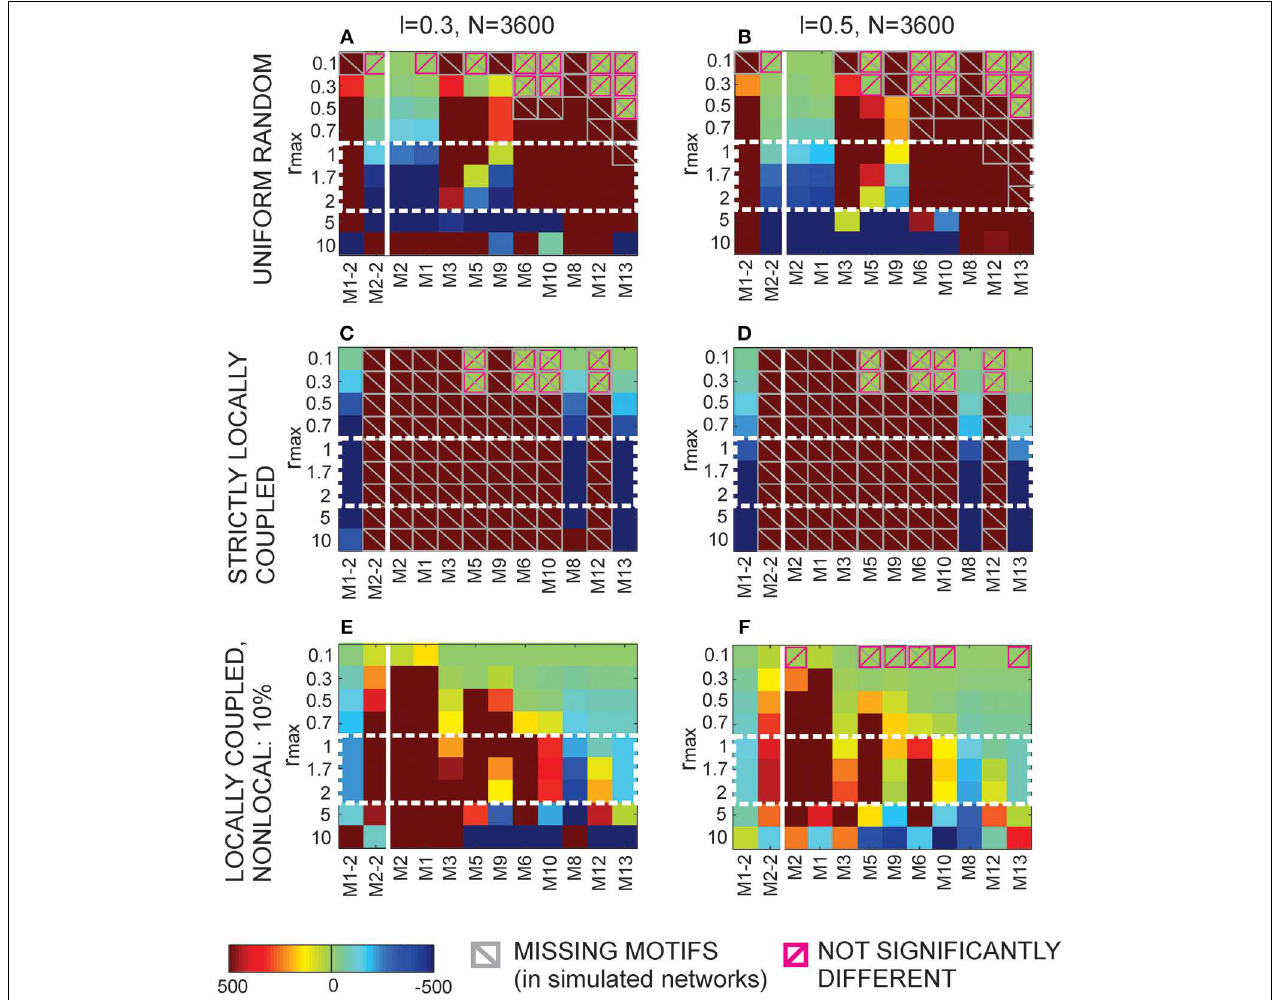
the same format as Figure 7 , while the color bar at the bottom explains the FIGURE 8 | Comparison of the results from Figure 7 with the motif color code. The crossed gray squares correspond to zero motif counts in the counts obtained from simulated uniform random and locally coupled simulated networks, i.e., both the mean value and the variance are zero. The networks. The color maps show the t-scores for all motifs (shown on the x crossed pink squares are the cases when our model and the simulated axis) and all considered values of the normalized effective radius (shown on networks give statistically the same results (the t -test with 5% significance the y axis). The comparison is done for two population densities, a denser level). (A,B) Comparison with the uniform random networks. (C,D) one ( l 0 . 3 , left column) and a sparser one ( l 0 . 5 , right column). A positive = = Comparison with the strictly locally coupled networks. In these networks all t-score indicates a bigger expected number of motifs in our model than in connections are bidirectional and only motifs M1-2, M8, and M13 are the simulated network, while a negative t-score indicates a smaller expected possible. (E,F) Comparison with the locally coupled networks with 10% number in our model than in the simulated network. All the values outside the non-local connections. interval [ 500 , 500 ] are set to 500 . The scores are shown as color maps in − ± network. We marked them with gray crossed squares in the figure. When our model gives zero expected number of motifs, the case is marked with both gray and pink squares. Figure 7 . The color bar at the bottom of the figure explains the color code. The motif types are indicated on the x axis, and the values of the normalized effective radius are indicated on the y axis. The first row ( Figures 8A,B ) shows the comparison with the uniform random networks, the second row ( Figures 8C,D ) is the comparison with strictly locally coupled networks and the third row ( Figures 8E–F ) is the comparison with locally